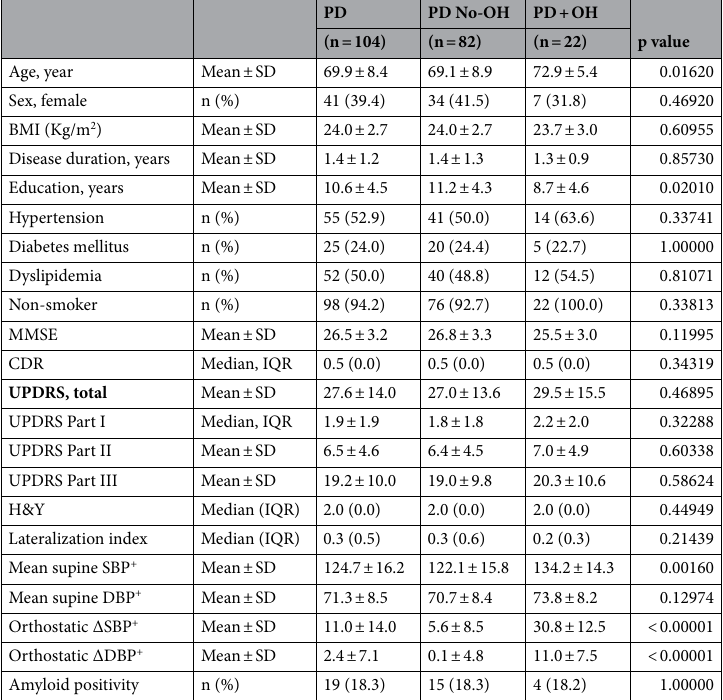
Table 1. Clinical characteristics. OH, orthostatic hypotension; BMI, body mass index; MMSE, Mini-Mental Status Examination; CDR, Clinical Dementia Rating; H&Y, Hoehn and Yahr; UPDRS, Unified Parkinson’s Disease Rating Scale; SBP, systolic blood pressure; DBP, diastolic blood pressure; SD, standard deviation; IQR, interquartile range. Group differences were compared using independent or Welch’s t-tests, Mann–Whitney U test or Fisher’s exact test, as appropriate. Statistical significance was defined as a two-tailed p < 0.05. + Blood pressure unit is